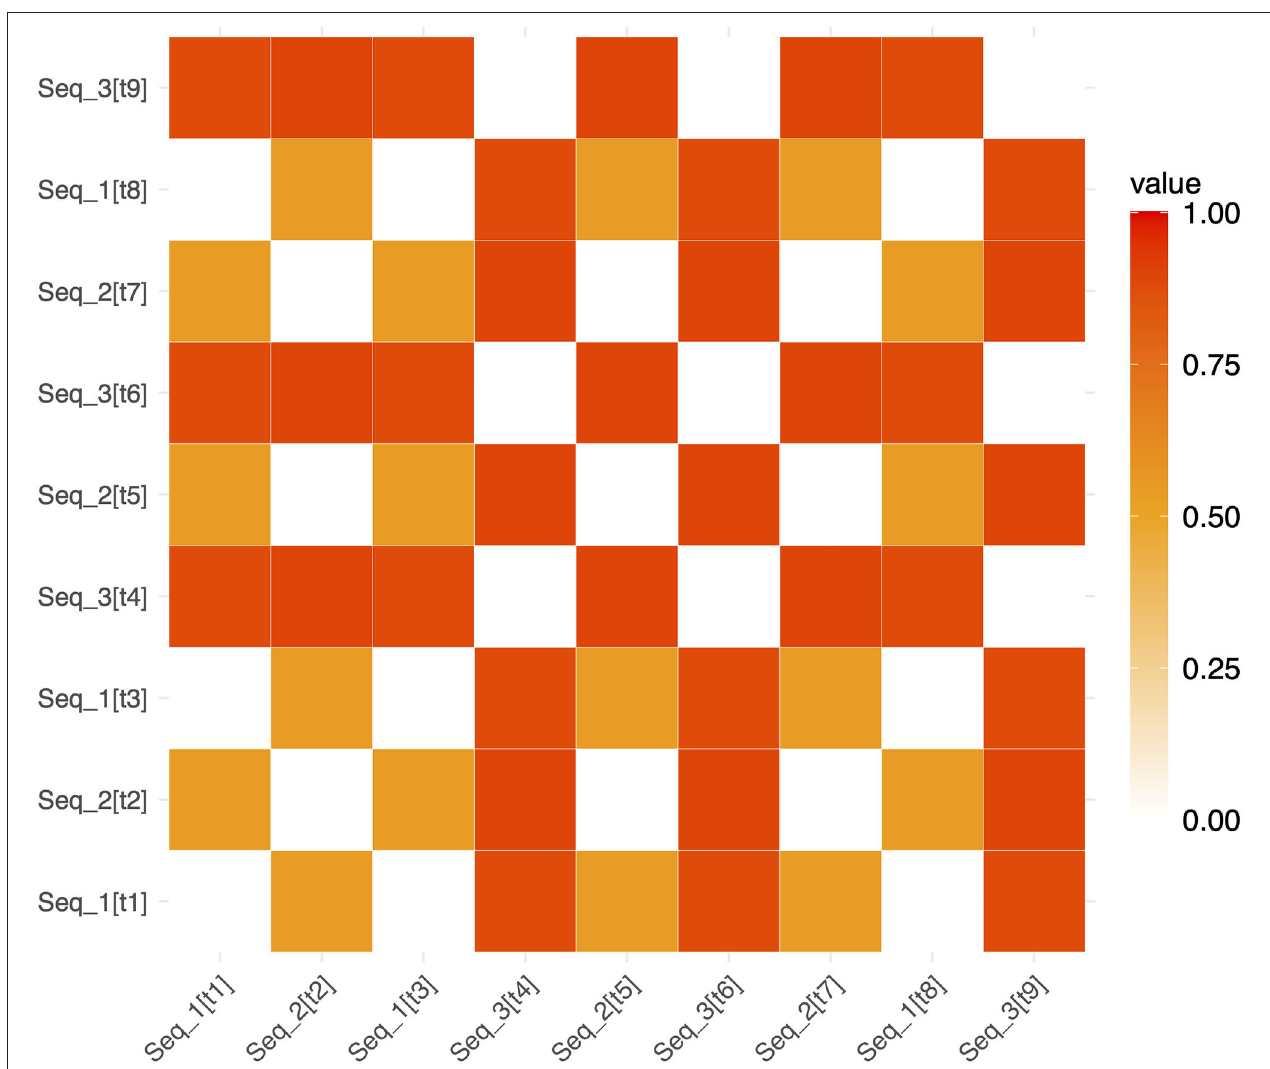
FIGURE 3 | Example representational dissimilarity matrix for repeated sequences. An example RDM for repeated sequences in a single run (for ease of visualization). White squares show pairs of trials involving the identical repeated sequence (and therefore have a dissimilarity of 0). Red and orange squares show the dissimilarity between pairs of non-identical repeating sequences (e.g., Seq1 and Seq2). The notation [tn] refers to the trial number within a run. [t1] refers to “trial 1” and [t2] refers to “trial 2”, etc. (e.g. Seq_2[t7] denotes that Seq2 was presented on trial